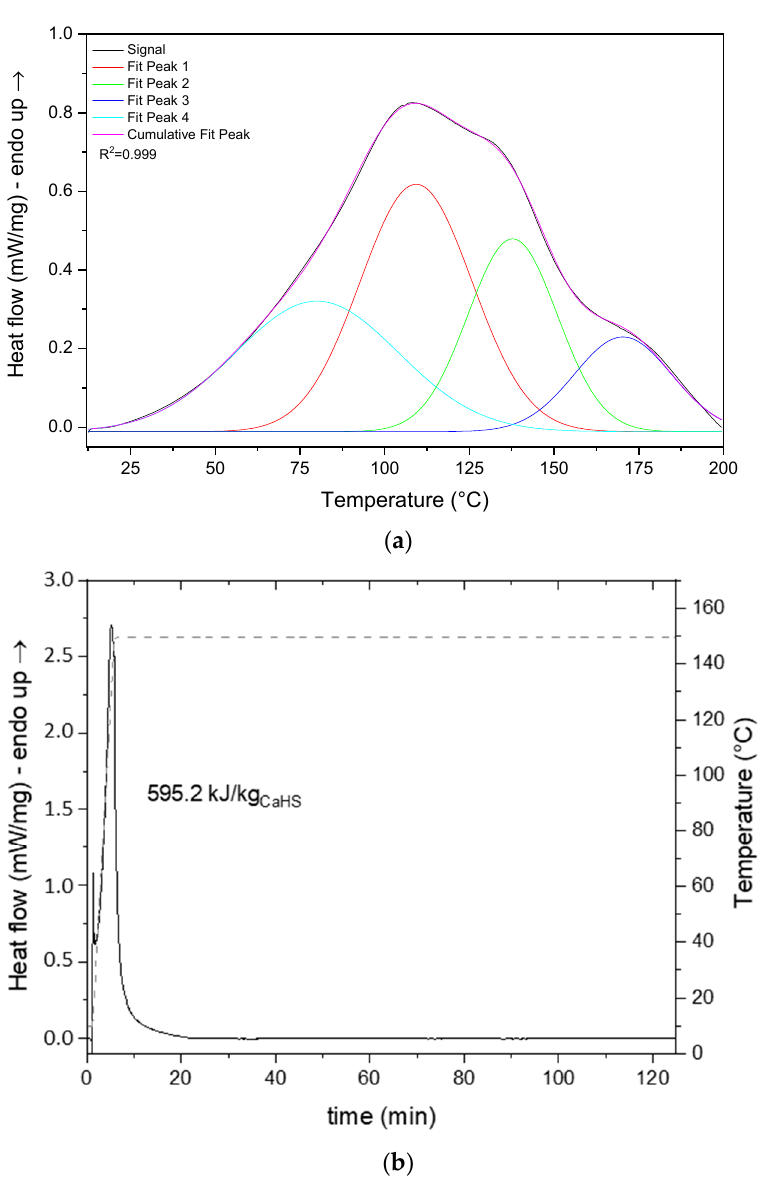
Figure 9. DSC thermogram of CaHS ( a ) under ramping and ( b ) isothermal conditions. A comparison between CaHS and other selected common inorganic salt hydrates studied for thermochemical energy storage is reported in Table 1. Table 1. List of thermophysical characteristics (moles of H 2 O involved in the dehydration process (n); molar enthalpy of dehydration per moles of material ( Δ H (kJ/mol)); heat storage capacity per mass (Q M ); and volume (Q V ) of material) and working conditions (dehydration (T deh ) and hydration (T hyd ) temperatures) of CaHS and other selected common inorganic salt hydrates.